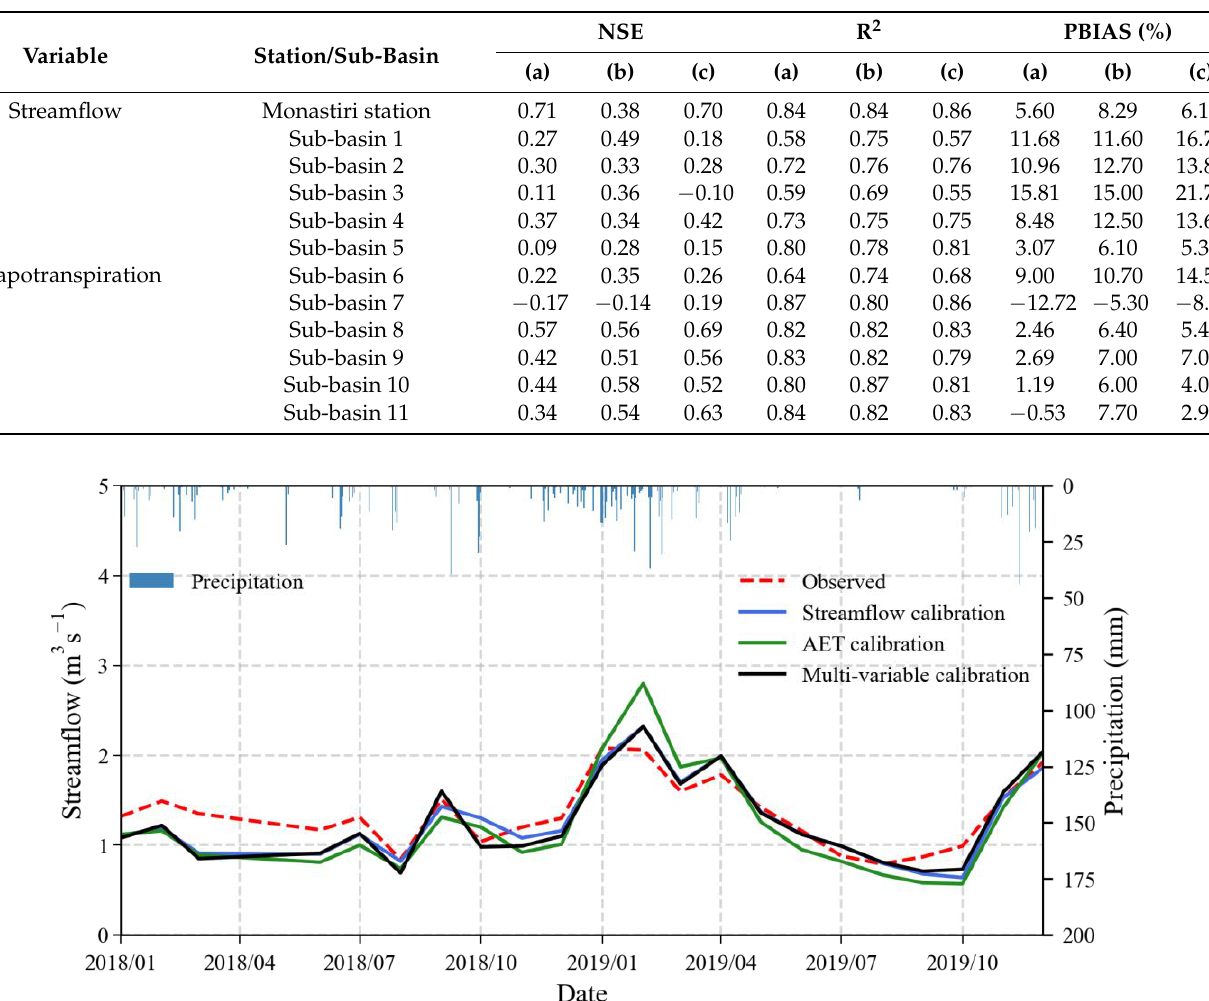
Table 3. Model evaluation statistics for each calibration scenario; (a) Streamflow calibration, (b) AET calibration, and (c) Multi-variable calibration. The location of the sub-basins 1–11 is indicated in Figure 2a–c.